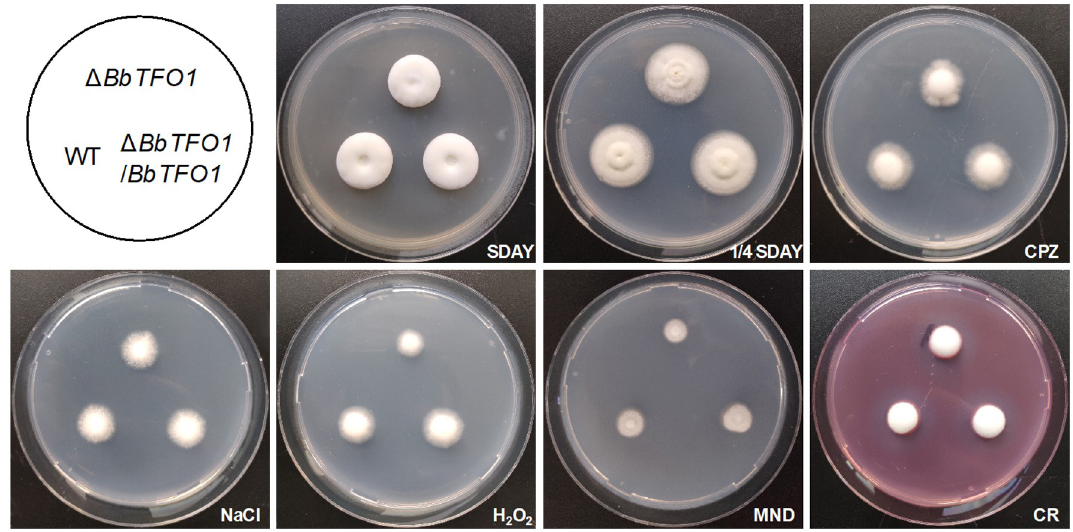
Fig 1. The growth of fungal colonies on SDAY, 1/4 SDAY, CPZ and CPZ containing NaCl (0.5 M), H 2 O 2 (2 mM), menadione (MND: 0.2 mM) and Congo red (CR: 3 μ g ml − 1 ). The media were incubated for a period of 7 days at 25˚C, and then photos were taken. Note that the Δ BbTFO1 strains of BbTFO1 grew smaller than the WT and Δ BbTFO1 / BbTFO1 strains on CPZ containing H 2 O 2 and